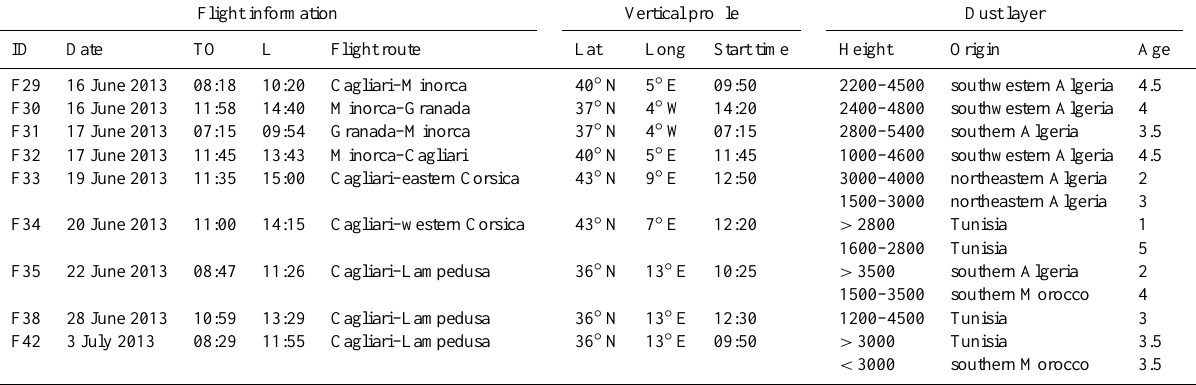
Table 1. Detailed information about the flights (number (ID), date, take-off time (TO), landing time (L) and route), the vertical profiles (lati- tude (lat), longitude (long) and start time) and the dust layers sampled (height in metres, origin, age in day) during the ChArMEx/ADRIMED airborne campaign. Times are expressed in coordinated universal time (UTC).